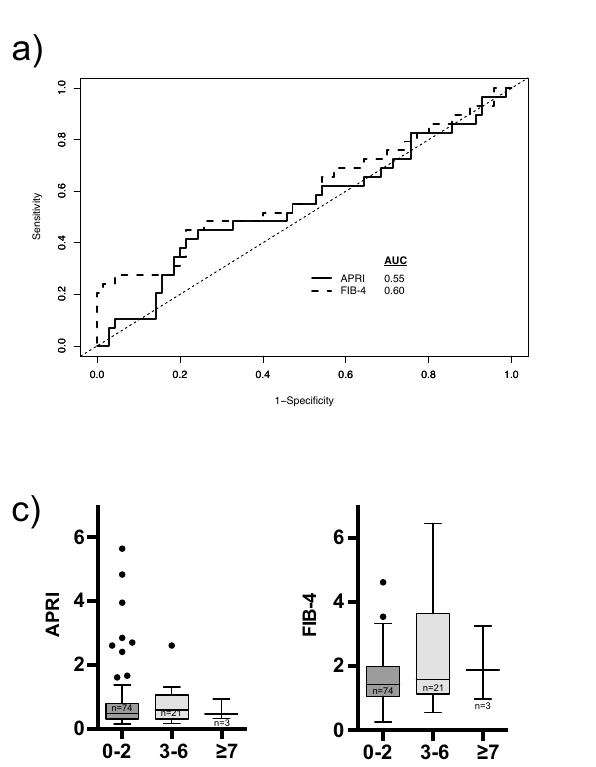
Figure 2. Diagnostic fidelity and correlation with histopathological scores of APRI and FIB-4. Receiver operating curves of APRI (solid black line) and FIB-4 (dashed black line) ( a ). Tukey Boxplots demonstrating APRI and FIB-4 in patients grouped according to their point values in Ishak fibrosis staging ( b ) and LAF-score ( c ). Kruskal–Wallis test and Bonferroni’s post-hoc test were used to compare